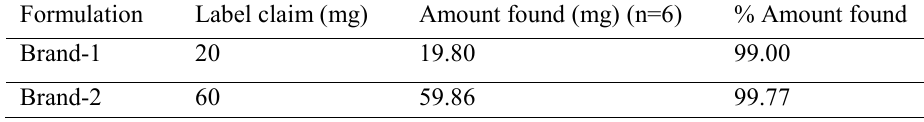
Table 4: Recovery from dosage